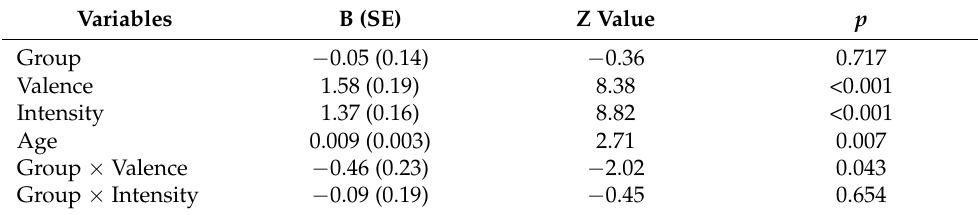
Table 5. Summary of the most plausible-fitting model predicting accuracy in emotion